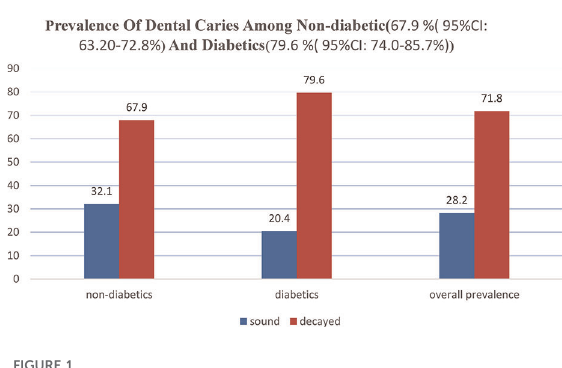
FIGURE 1 Prevalence of dental caries among nondiabetic and diabetic